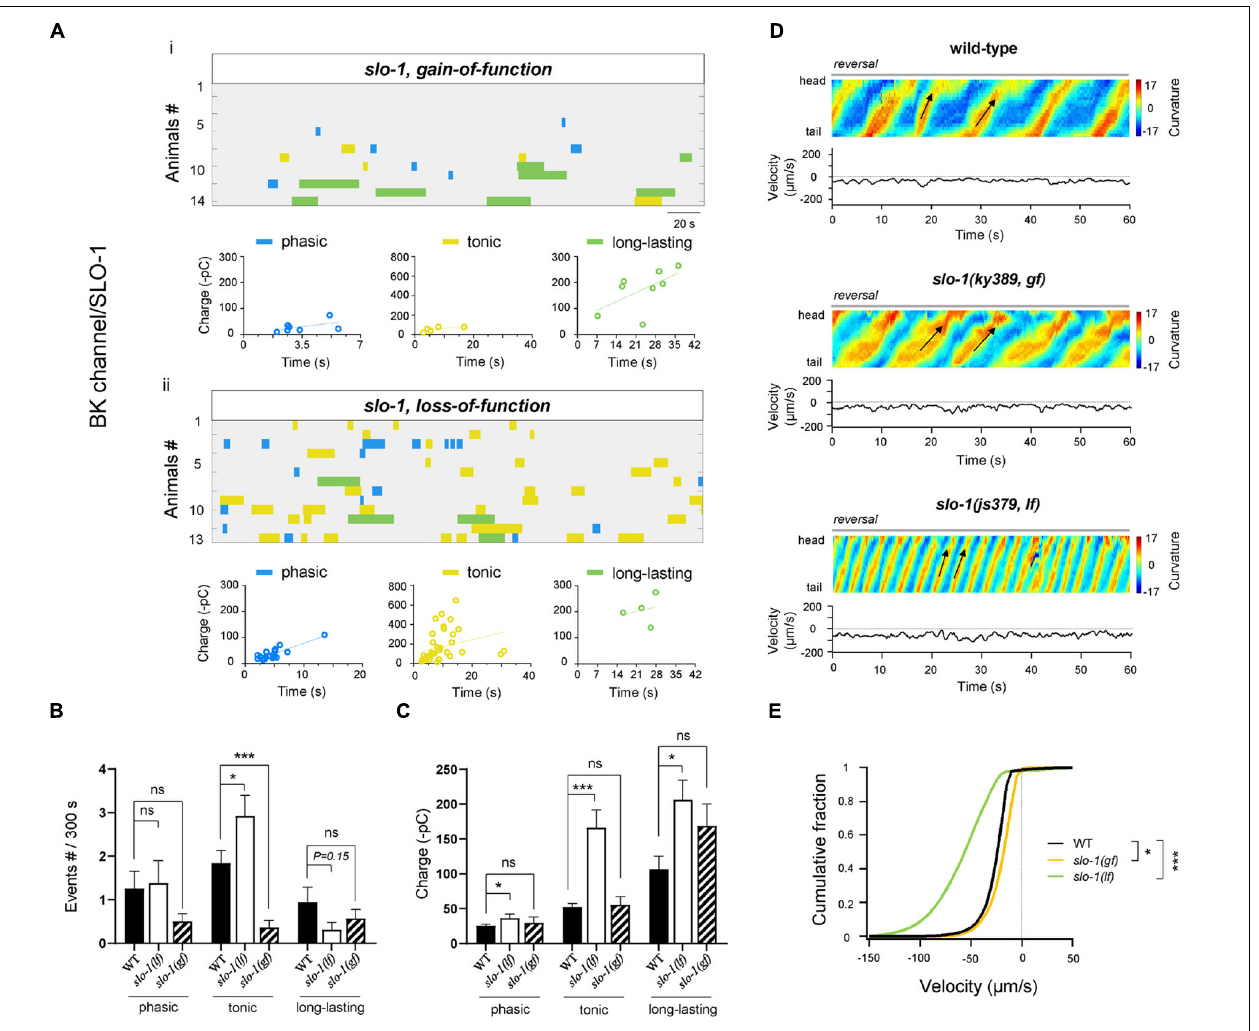
FIGURE 5 | BK/SLO-1 channel inhibits tonic- and phasic-type rPSCs. (A) Colormap and charge efficiency (linear fitting) of all rPSC events recorded from ablated slo-1(ky389; gf) and slo-1(js379; lf) mutant animals, respectively. Blue dots denote phasic-type events, yellow dots denote tonic-type events, and green dots denote long-lasting-type events. (B,C) Quantification of the frequency and charge of different rPSCs in respective genotypes with premotor INs and B-MNs ablation. n ≥ 14 animals in each group. (D) Representative curvature kymogram ( up ) and instantaneous velocity ( bottom ) of free-behaving animals of respective genotypes. slo-1(js379; lf) mutant animals exhibit faster reversal, as posterior to anterior propagating body bends (arrows). (E) Distribution of instantaneous velocity of wild-type, slo-1(ky389; gf), and slo-1(js379; lf) mutant animals. The velocity fraction is drastically left-shifted in slo-1(js379; lf) mutants, and right-shifted in slo-1(ky389; gf) mutant animals. n ≥ 10 animals in each group. * p < 0.05, *** p < 0.001 against ablated wild-type by the Kolmogorov–Smirnov test. All data are expressed as means ± SEM. Student’s t -test was used (B,C) . Statistical significance is indicated as follows: ns, not significant, * p < 0.05, *** p < 0.001 in comparison with that as